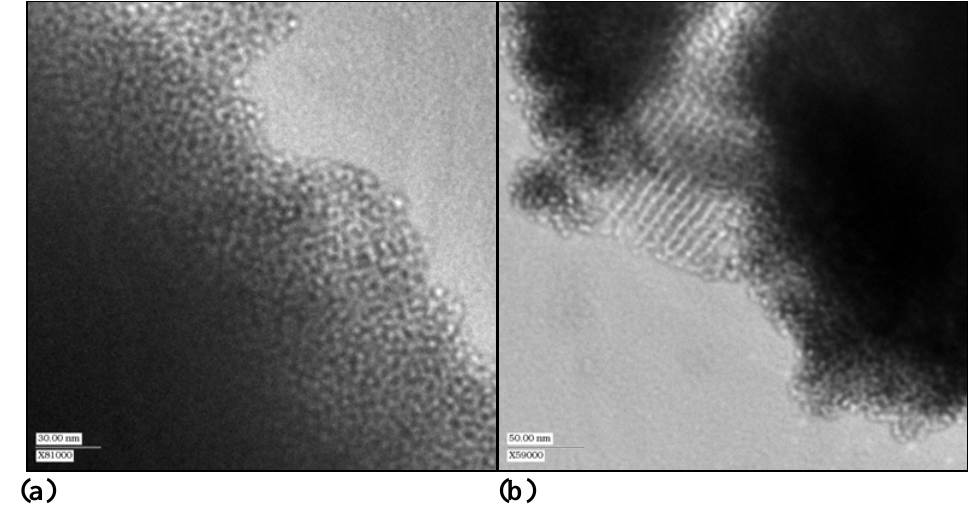
Figure 1. Powder X-ray diffraction diagram of mesoporous SnO indicates a disordered mesopore structure.